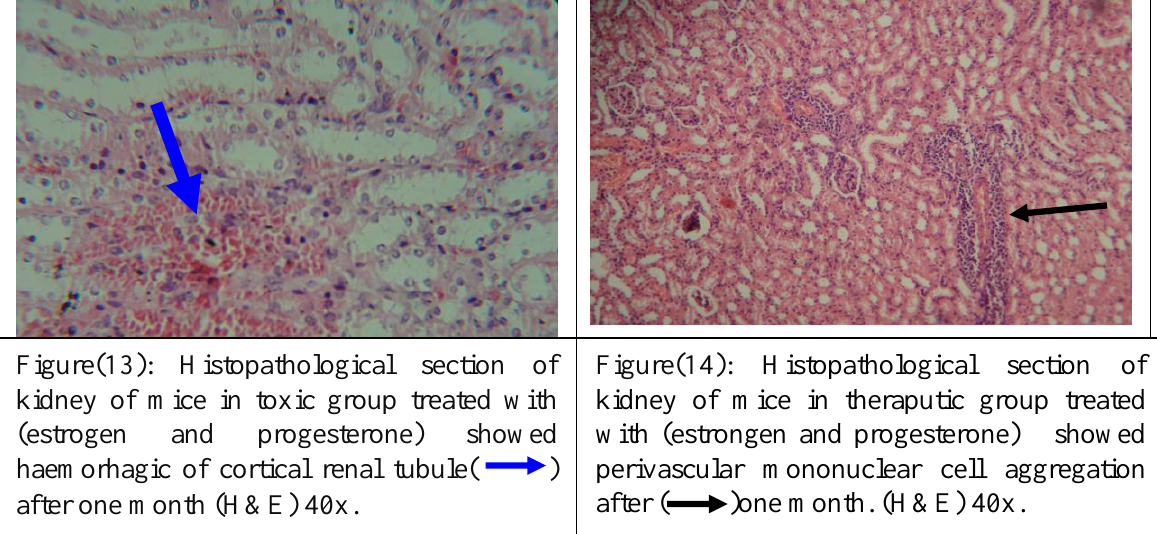
Figure(14): Histopathological section of kidney of mice in theraputic group treated with (estrongen and progesterone) showed perivascular mononuclear cell aggregation after ( )one month. (H&E)